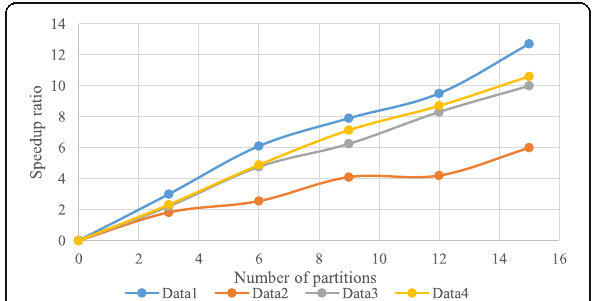
Fig. 3 Speedup performance test on different datasets